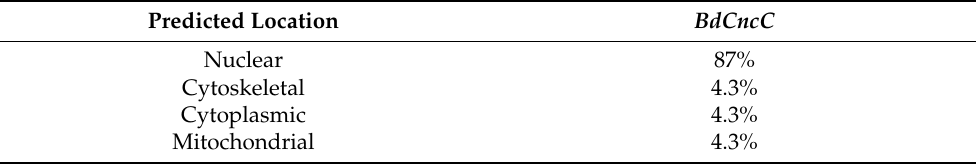
Table 2. Subcellular localization prediction of BdCncC .